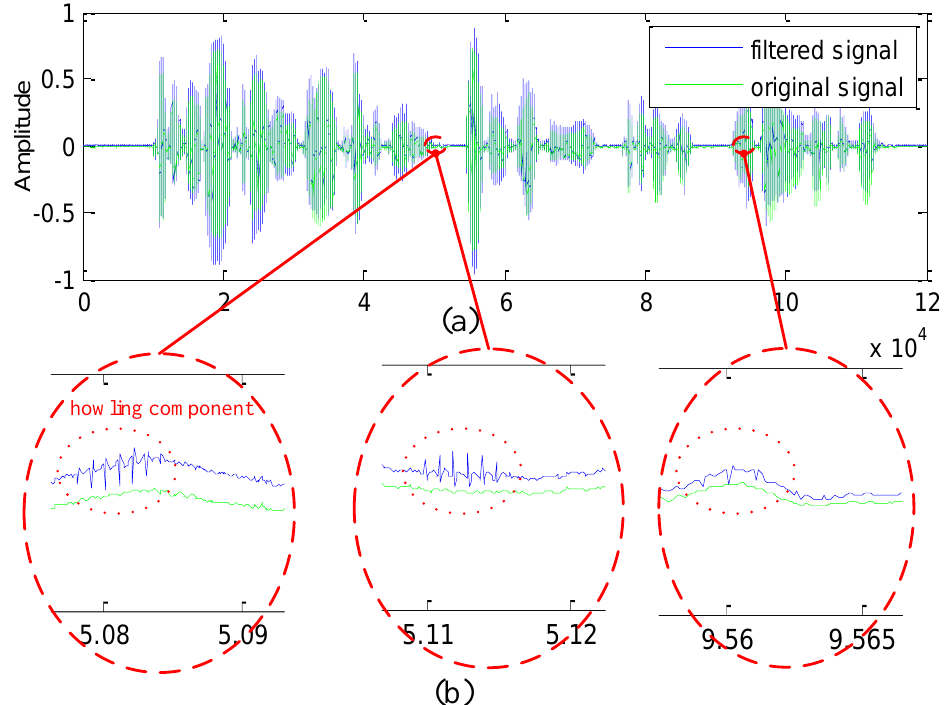
Figure 9. The signal waveforms filtered by the IIR notch filter: ( a ) The original waveform and the filtered waveform; ( b )The enlarged waveform.